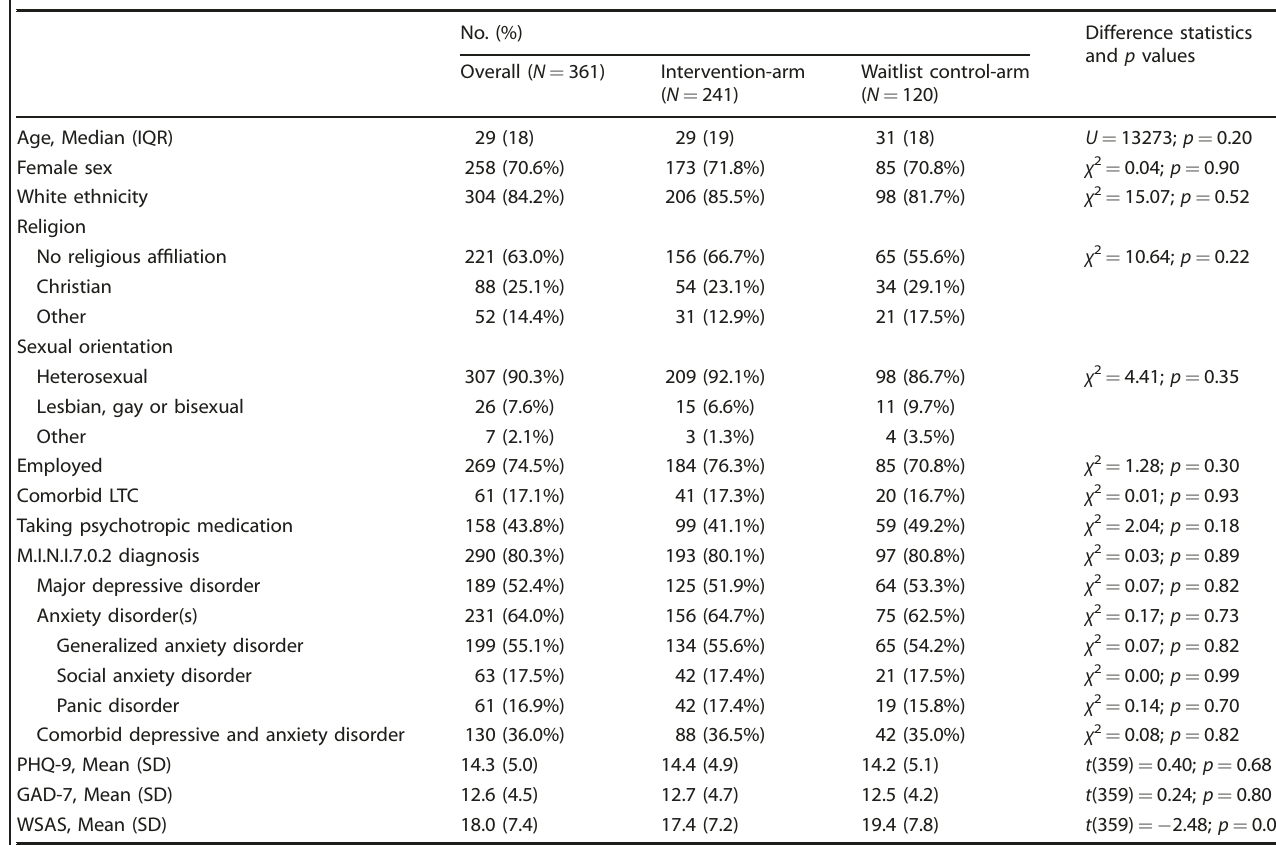
Table 1. Baseline characteristics of study